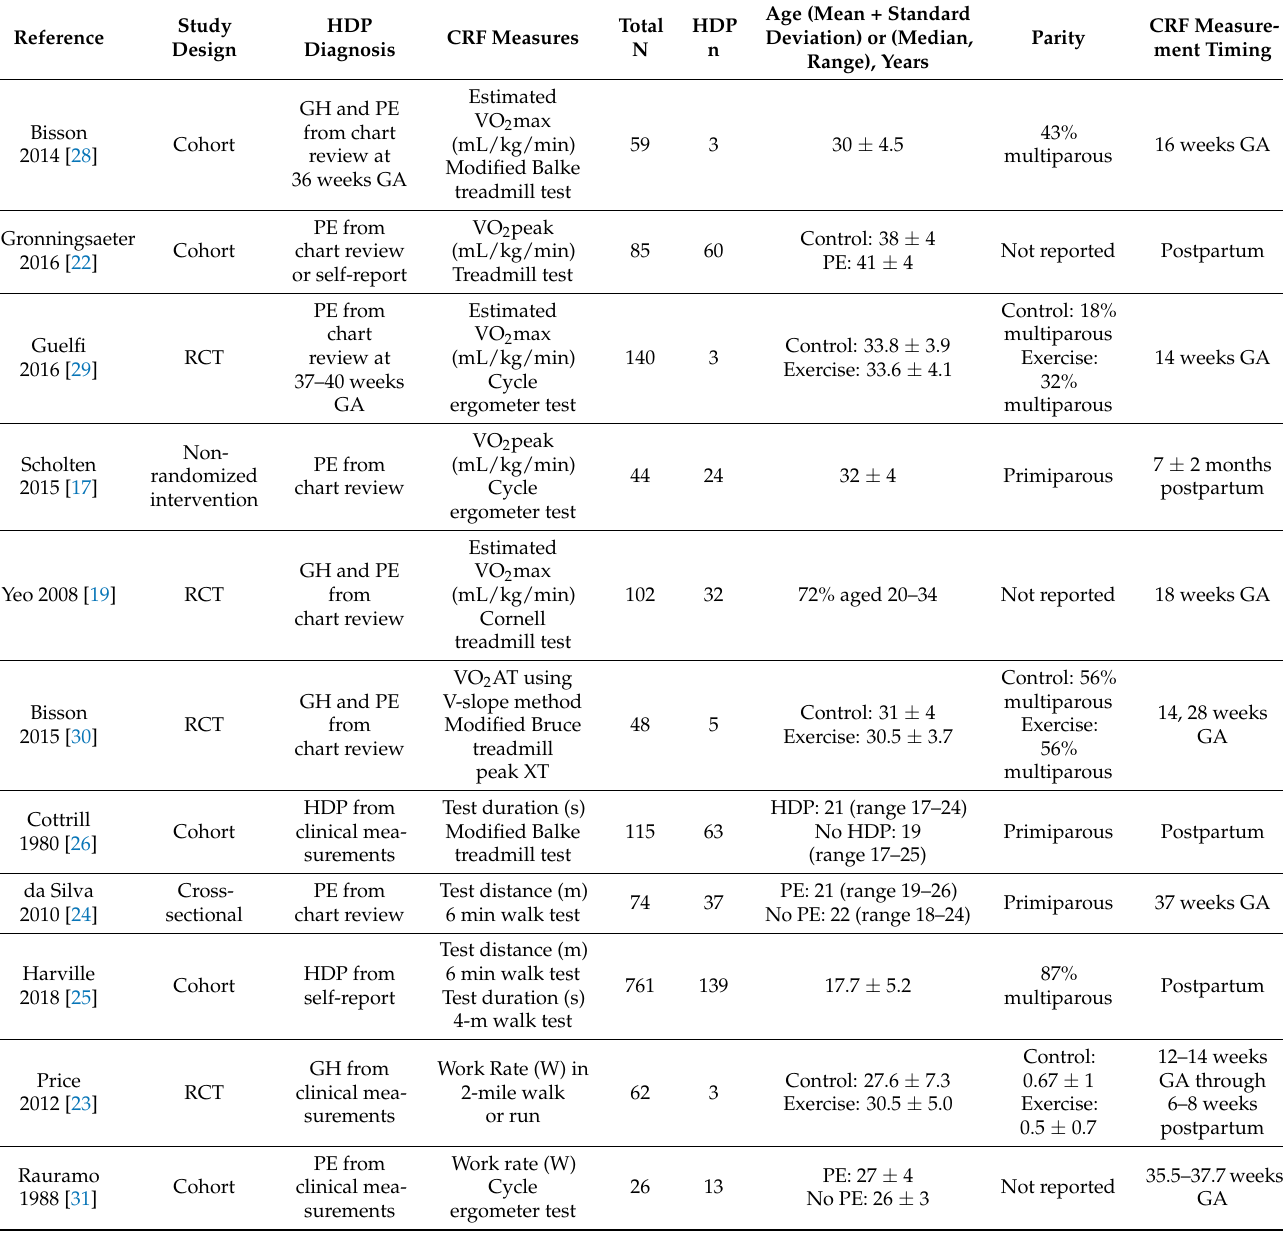
Table 1. Study and participant